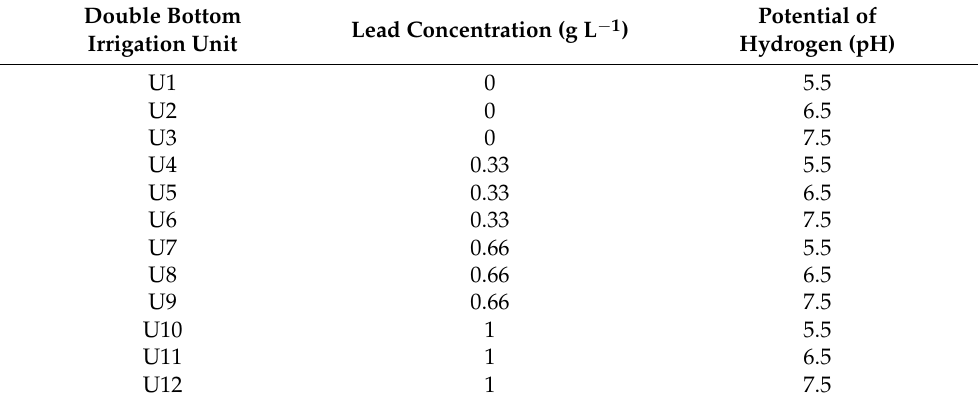
Table 4. Experimental